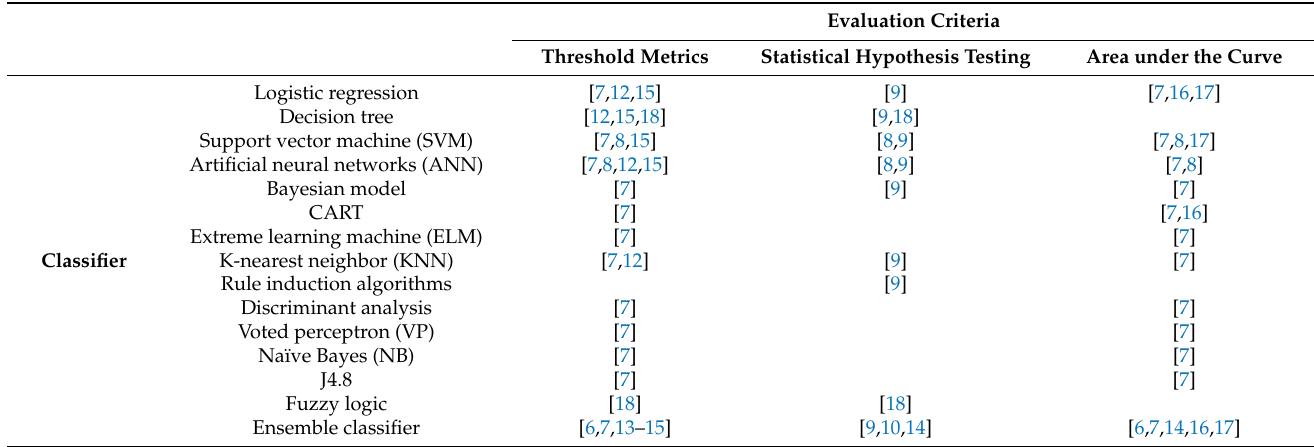
Table 1. Machine learning in credit scoring: classification algorithms and evaluation criteria